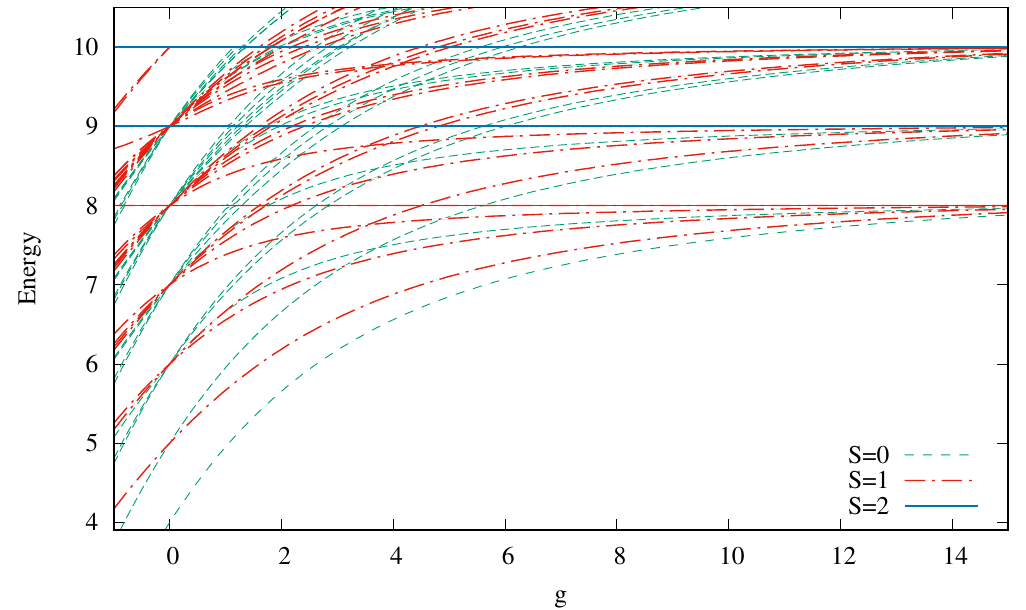
Figure 9. Low-energy spectrum of the fermionic system with four particles as a function of the interaction strength. The states are labelled according to their total spin, as explained in the